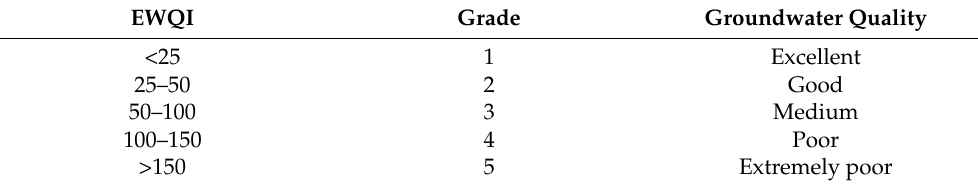
Table 1. Groundwater quality classification criteria according to EWQI